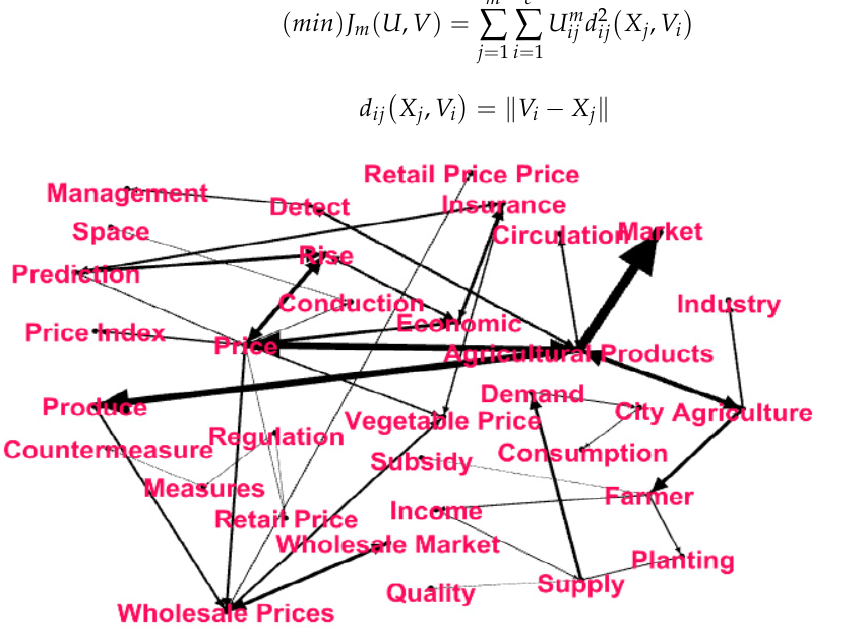
Figure 10. Cluster Analysis Diagram.